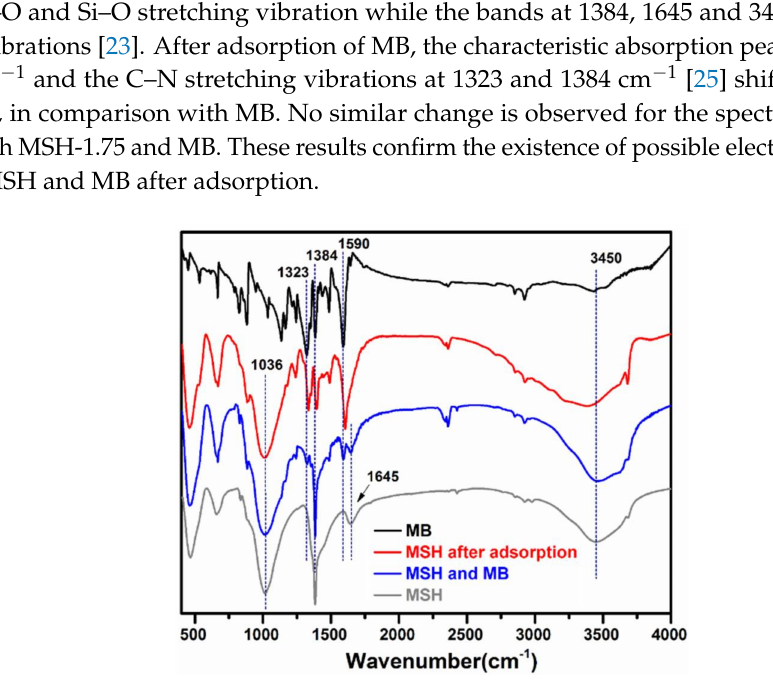
Figure 4. Fourier transform infrared spectroscopy (FT-IR) spectra of methylene blue (MB), mixture of MSH-1.75 and MB, and MSH-1.75 before and after adsorption of